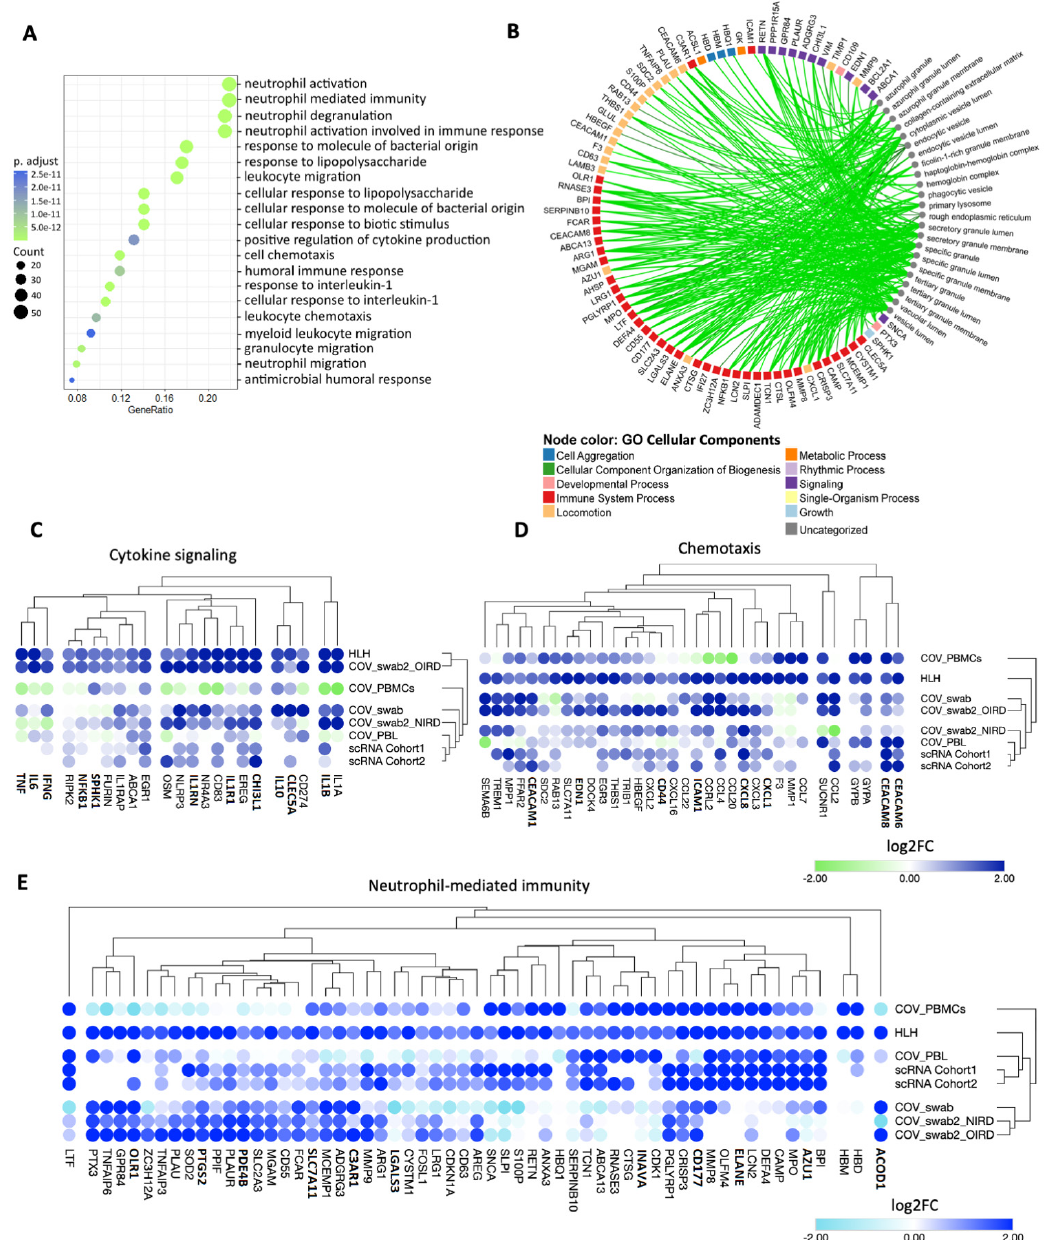
Figure 2. Cytokine/chemotaxis and neutrophil-associated transcriptional signatures predominate in the COVID-19 and HLH overlap. ( A ) Dot plot showing the most significant biological processes (BP) enriched by the 237 common up-regulated transcripts of COVID-19 and HLH datasets. The dot size is proportional to the number of genes enriching the gene ontology (GO) term and color proportional to adjusted p -value (green > significant than blue). ( B ) Network highlighting genes and cellular component (CC) associations. Only enriched terms with adjusted p -value < 0.05 are shown by small grey circles. The degree of associations is displayed by edge color and thickness (e.g., lighter colors and thinner edges signify fewer connections). Node color represents different GO CCs. Both enriched CCs and BPs were analyzed using ClusterProfiler with R programming. ( C – E ) Bubble heatmaps showing the hierarchical clustering based on Euclidian distance of expression patterns of genes associated to ( C ) cytokine signaling, ( D ) chemotaxis, and ( E ) neutrophil-mediated immunity in COVID-19 and HLH datasets. The color of circles corresponds to log2 fold change (log2FC). Pleiotropic genes belonging to more than one category are bold (Supplementary Table